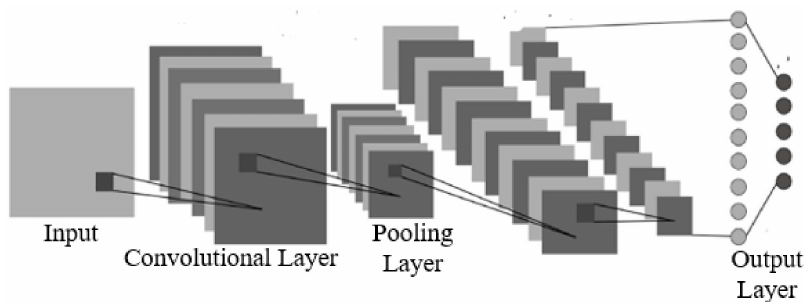
Figure 2. Convolutional neural network architecture